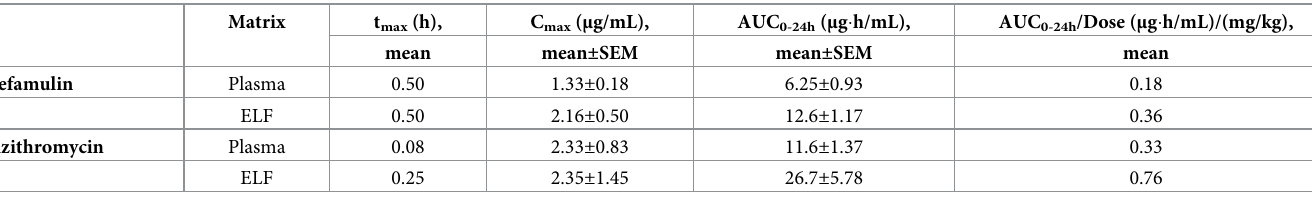
AUC 0-24h = area under the curve from time 0 to 24 hours; C max = maximum observed plasma concentration; ELF = epithelial lining fluid; t max = time of maximum observed